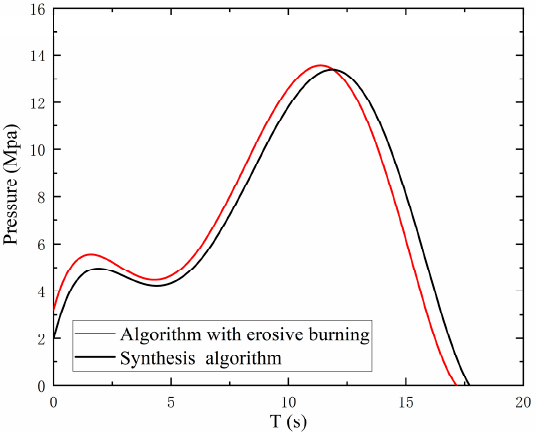
Figure 15. Comparison of the burning surface area of geometric theoretical value with synthesis algorithm under erosive burning and under geometrical law of burning.